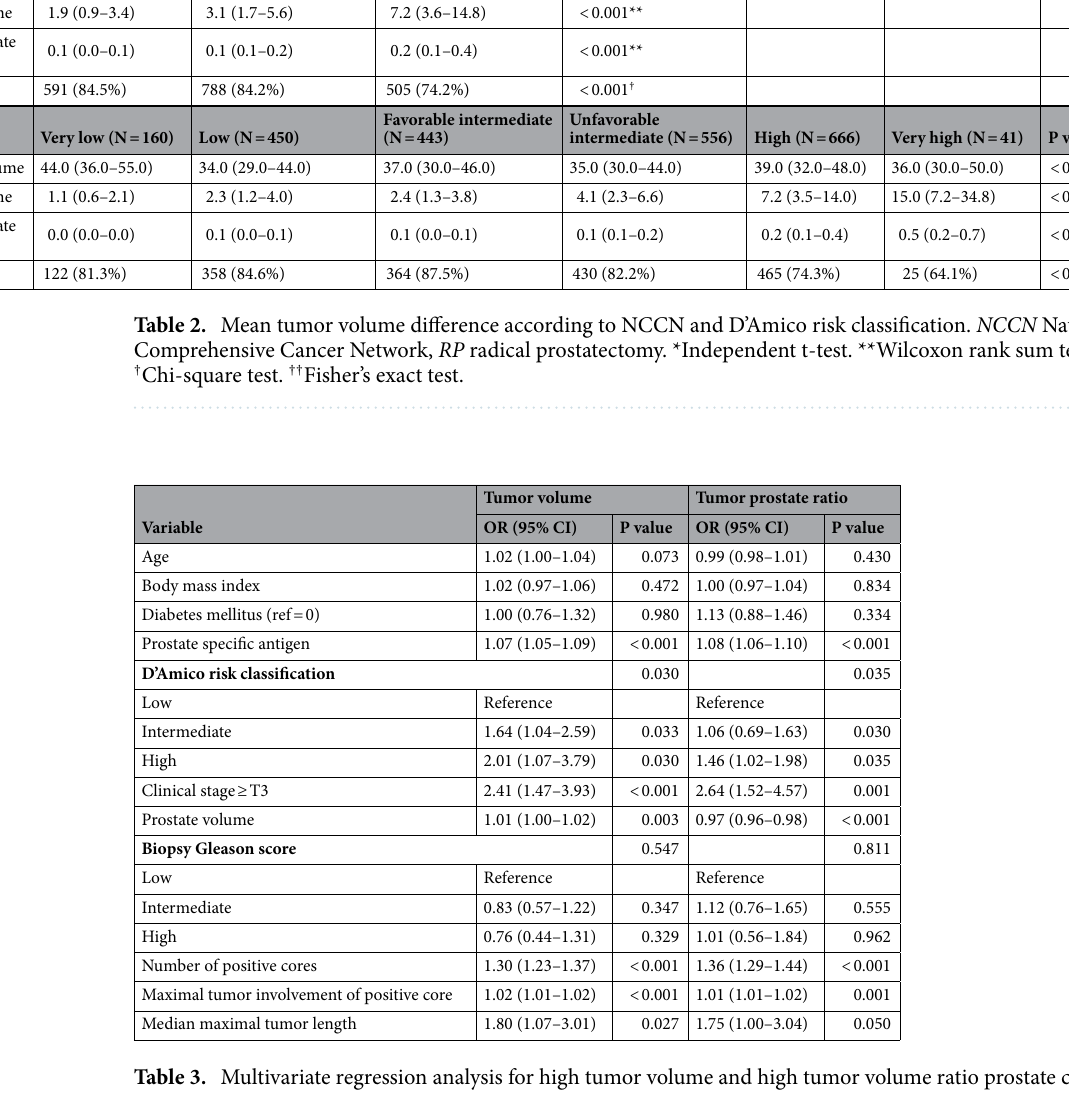
Table 3. Multivariate regression analysis for high tumor volume and high tumor volume ratio prostate cancer